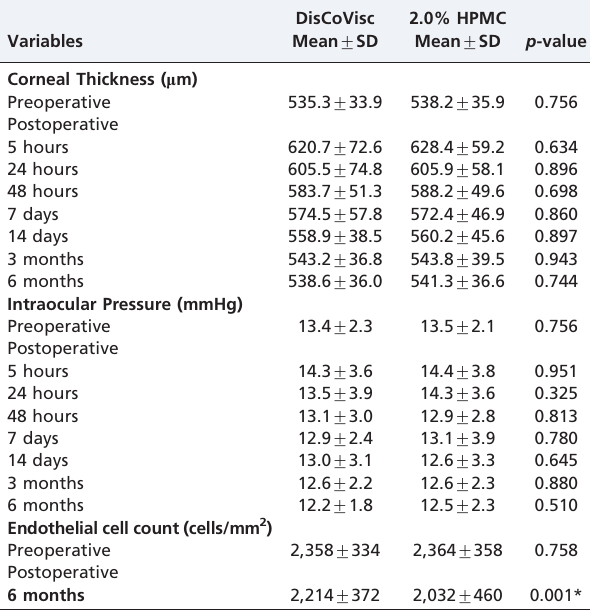
Table 2 - Primary outcome variables (DisCoVisc versus HPMC